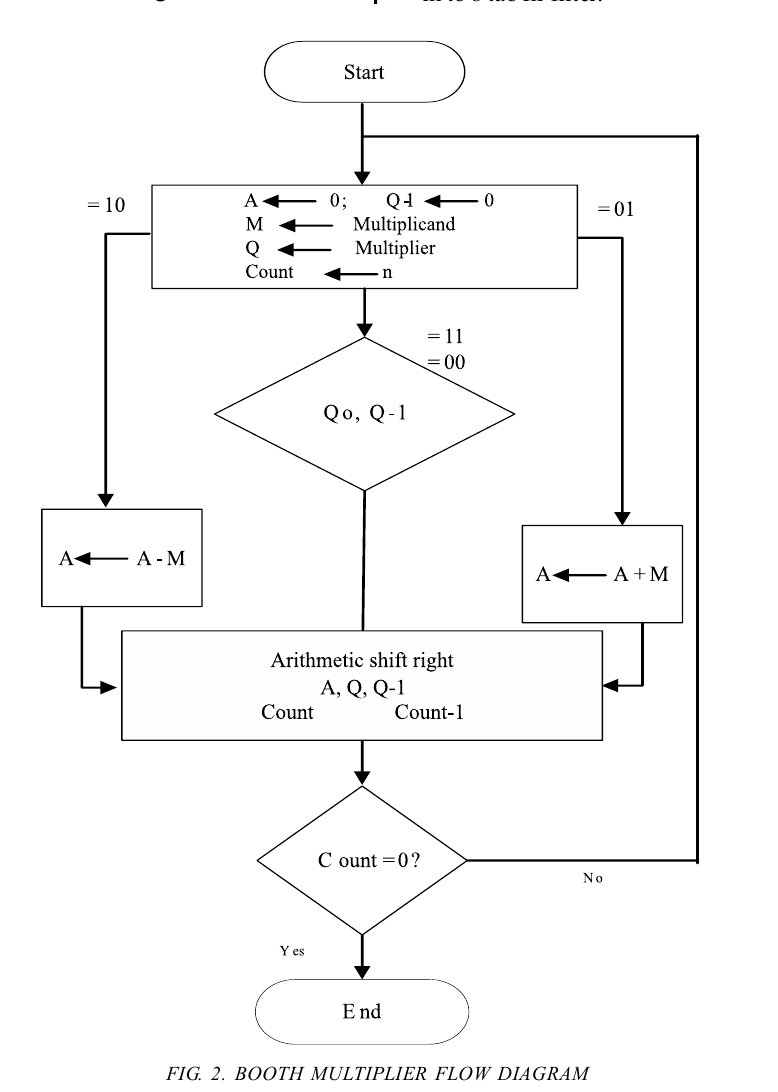
FIG. 2. BOOTH MULTIPLIER FLOW